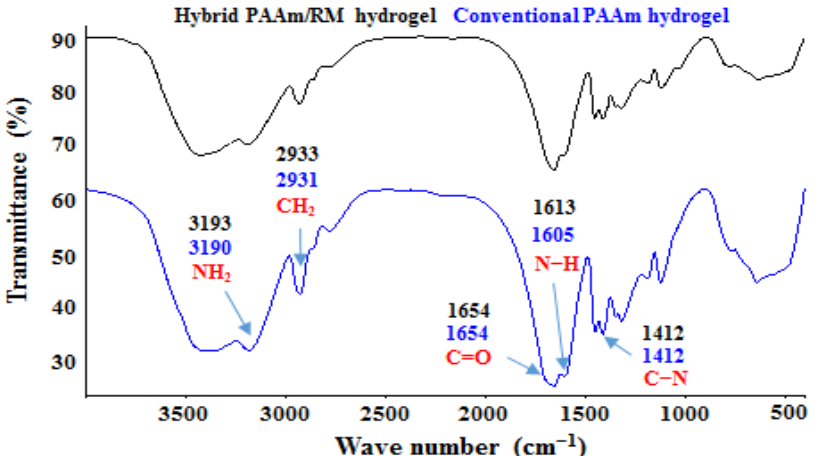
Figure 11. FTIR spectra for polyacrylamide and polyacrylamide/RM hydrogels (%RM = 10).